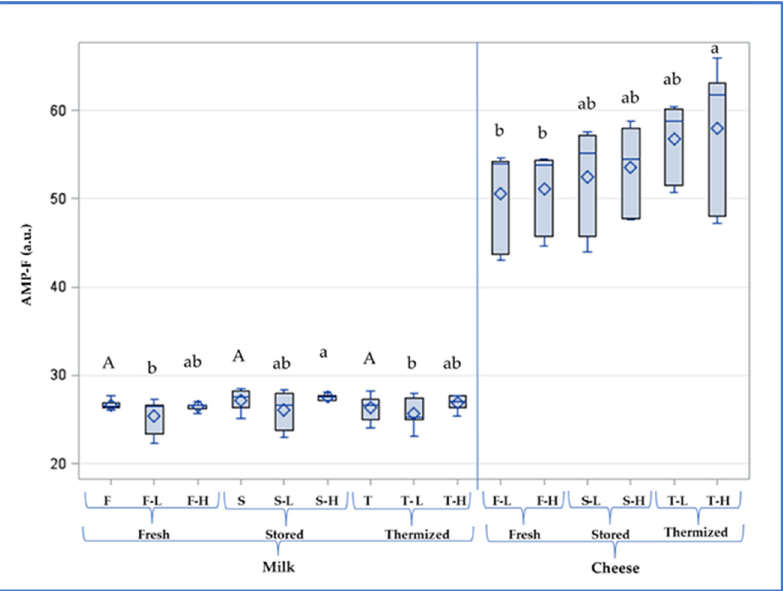
Figure 5. Comparison of AMP-F (advanced Maillard products fluorescence) in milk before pasteurization and after low and high pasteurization, and in the corresponding cheese made from each type of milk. Different letters indicate significant differences ( p < 0.05) within the group of milk or cheese. For the milk group, different capital letters were used in milk before pasteurization (F, S and T) while lowercase letters in milk after pasteurization (F-L, F-H, S-L, S-H, T-L, T-H). Milk before pasteurization: F = fresh milk, S = stored milk, T = thermized milk. Milk after pasteurization: L = low pasteurization (72 °C for 15 s), H = high pasteurization (77 °C for 15 s).